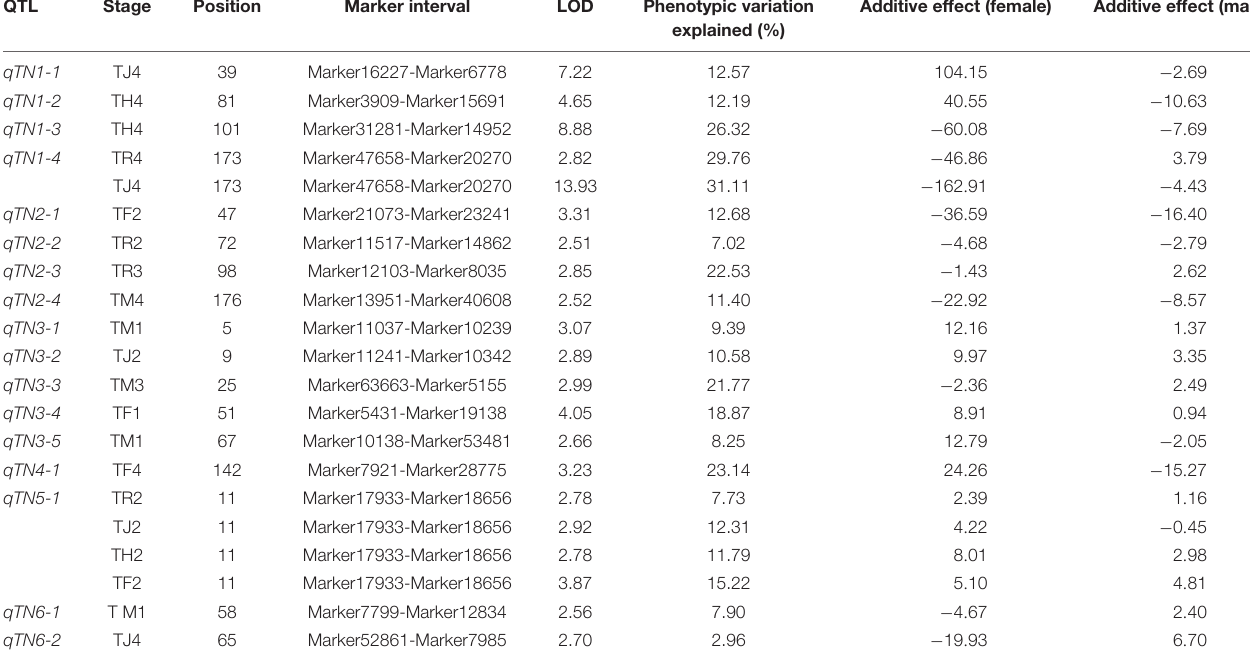
TABLE 2 | Unconditional quantitative trait locus (QTL) positioning of TN at different stages in A. Gaertn. QTL Stage Position Marker interval LOD Phenotypic variation